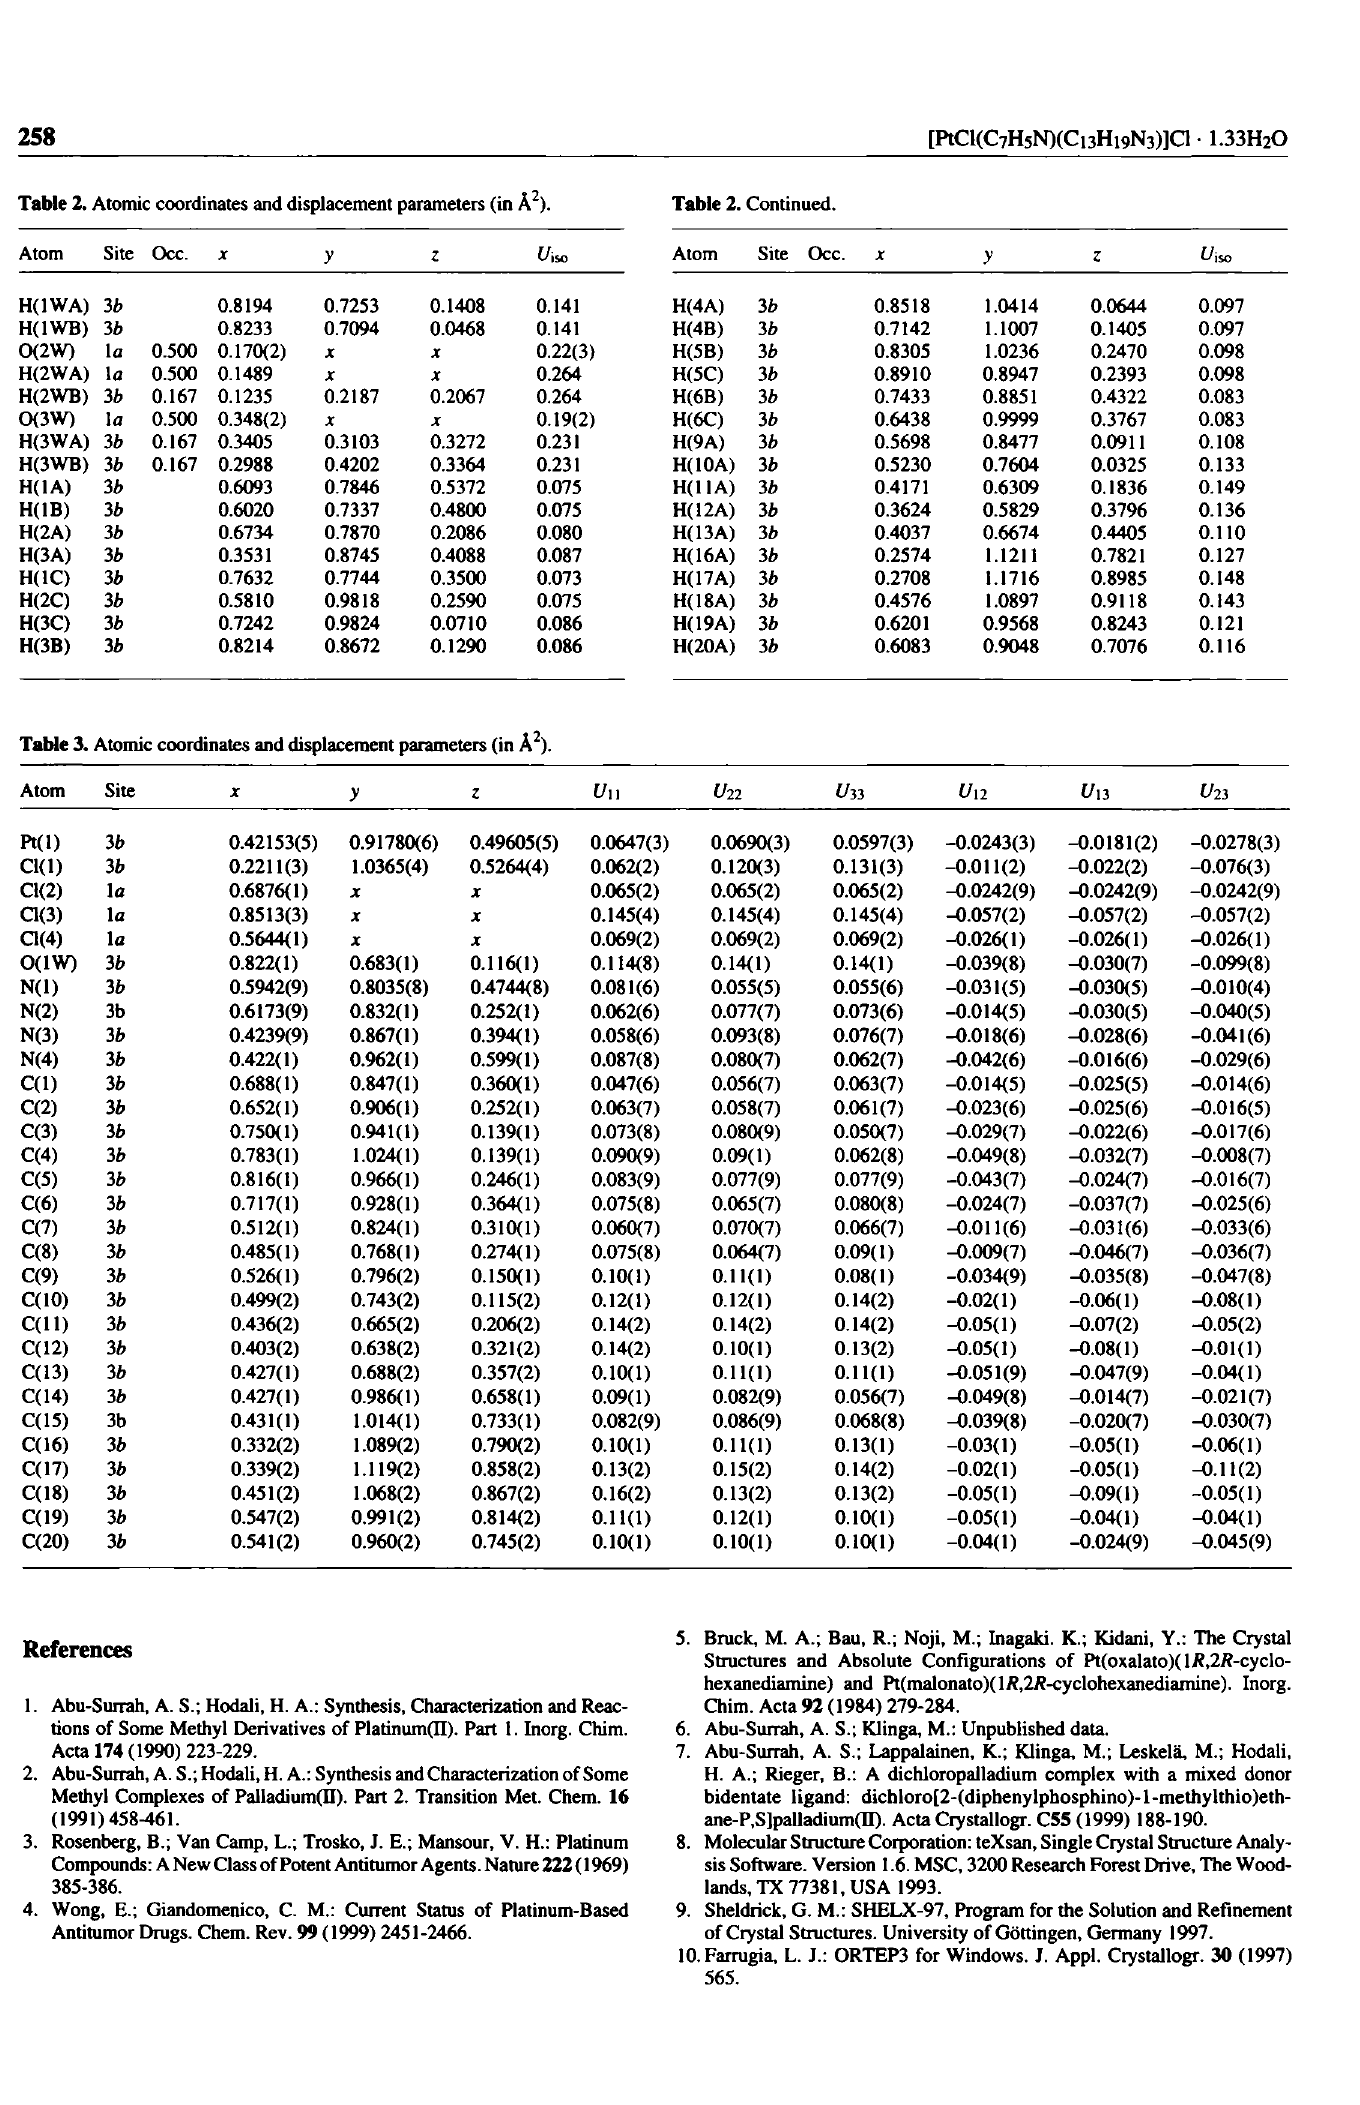
Table 3. Atomic coordinates and displacement parameters (in Â 2